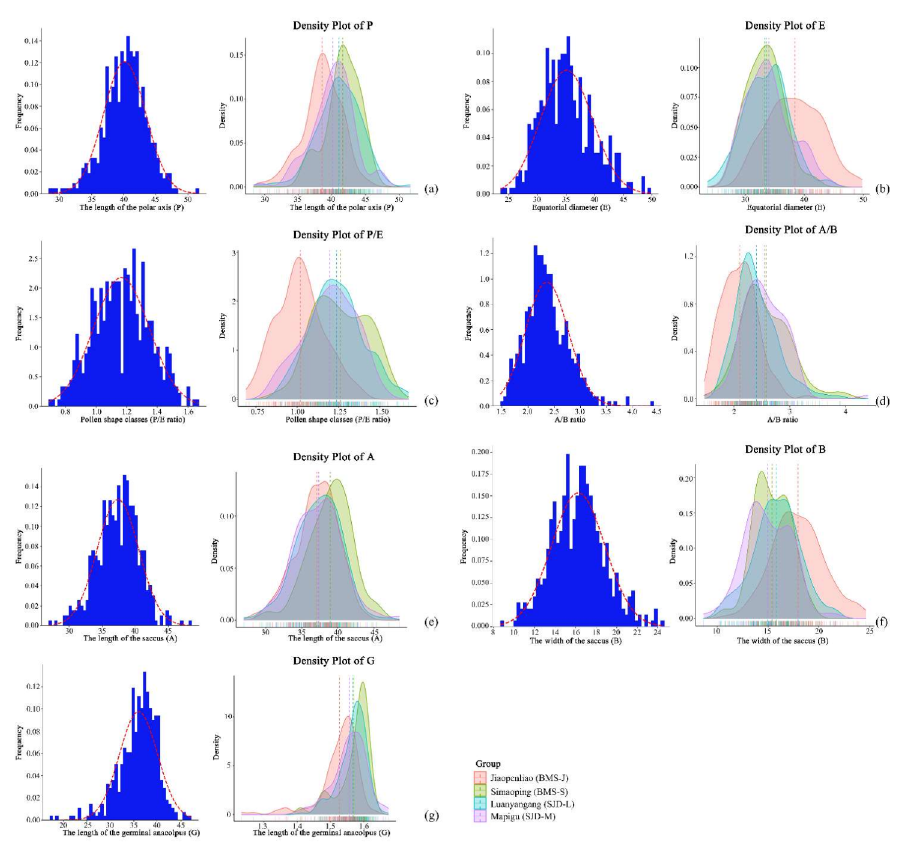
Figure 2. The frequency and density plots of seven pollen traits of C. argyrophylla based on 460 mea- sured pollen grains. Shown is the range value of P, E, P/E, A, B, A/B, and G for each individ- ual and population and the most frequent value of them, with populations ranked as